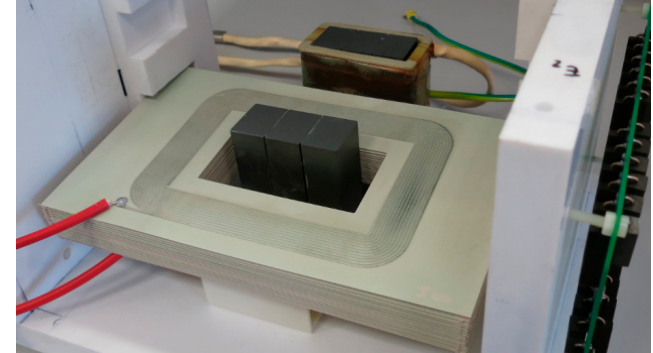
Figure 9. Secondary winding of the high-voltage transformer.